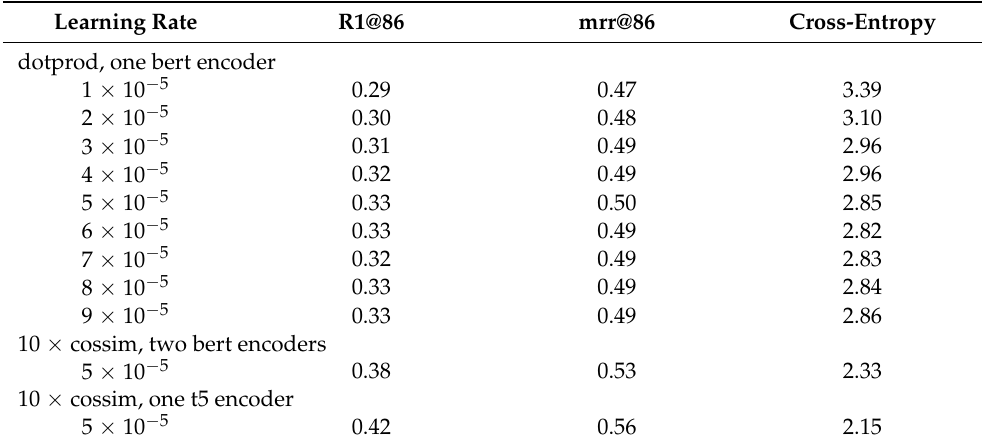
Table 3. The results of comparing models with different similarity functions for the task of ranking context–response pairs.